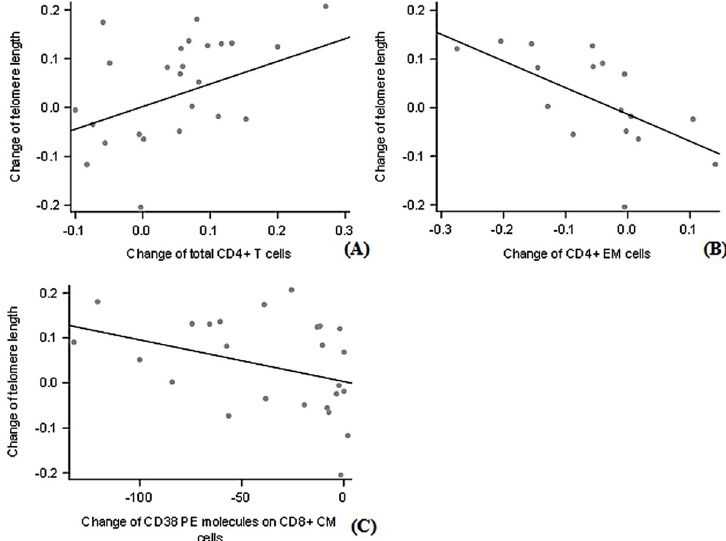
Fig 1. Correlation between baseline and 96 weeks after antiretroviral treatment initiation change in telomere length and change of the percentage of T cells subsets in participants from the VIDI substudy of NEAT 001 / ANRS 143 trial. Percentage of the CD4 + T cells (A), percentage of CD4 + effector memory (EM) cells (B) and the number of the CD38 + PE molecules on CD8 + central memory (CM) cells (C).